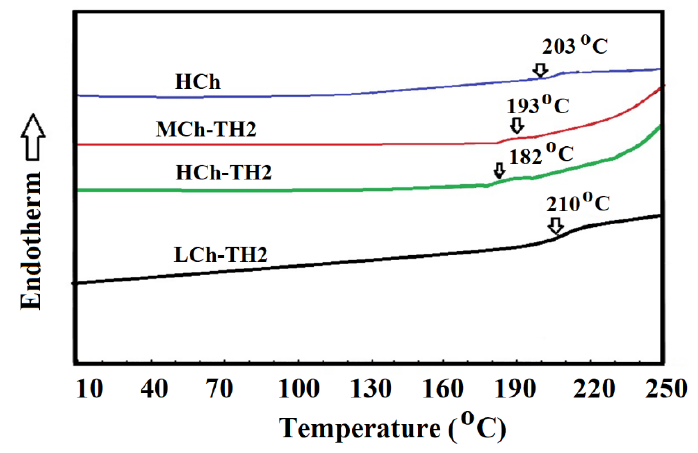
Figure 5. DSC thermograms of Ch-TH2 derivatives.